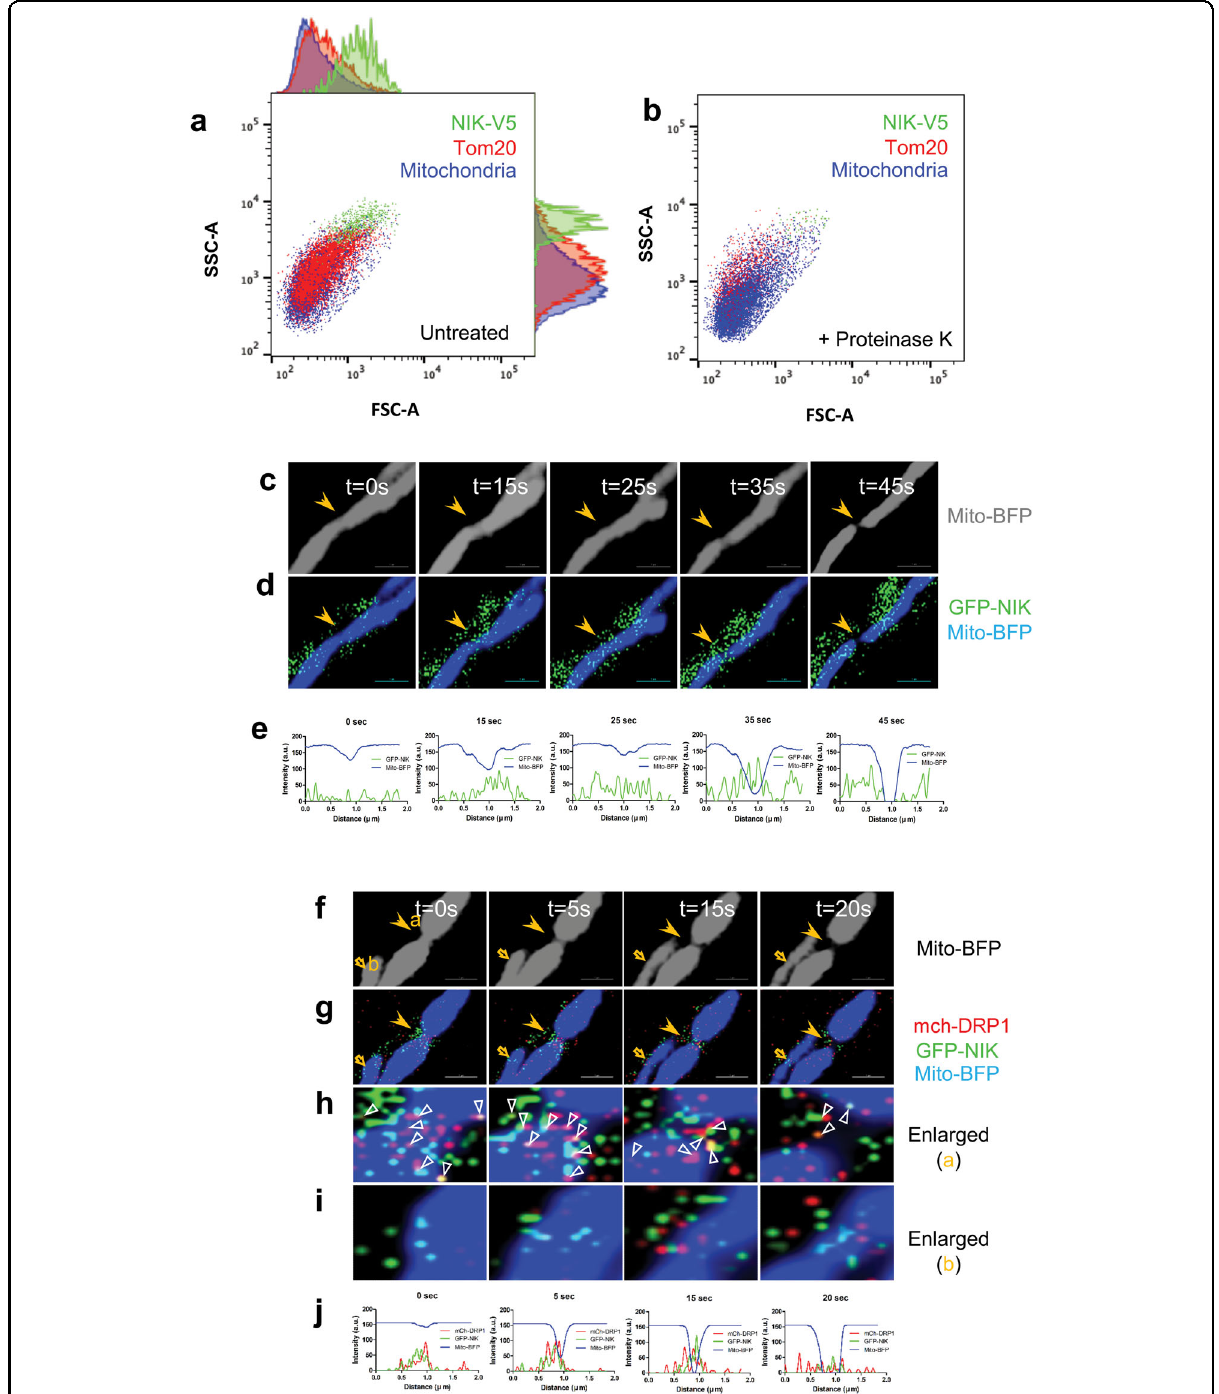
Fig. 1 (See legend on next